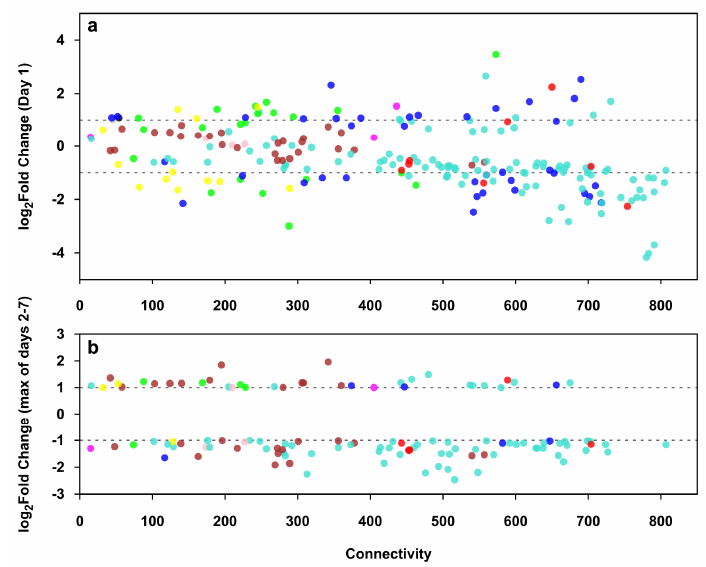
Figure 8. The expression and connectivity of differentially expressed transcription regulatory genes during villous trophoblast differentiation. Scatter plots show the relation of connectivity and expression change of transcription regulatory (TR) genes on day 1 ( a ) and on days 2 to 7 ( b ) of trophoblast differentiation. A co-expression network was calculated from the co-expression matrix of 220 differentially expressed TR genes and all 1937 differentially expressed genes, keeping only connections with a Pearson correlation coefficient r ≥ 0.9. Connectivity for each TR gene was defined as the number of its neighbors in the co-expression network. Fold changes in the expression of TR genes were calculated between each day and day 0 of the seven-day experimental differentiation period. Differentially expressed TR genes (|FC| ≥ 1 on any day) are shown in their respective module colors. ( b ) only shows TR genes not differentially expressed on Day 1.